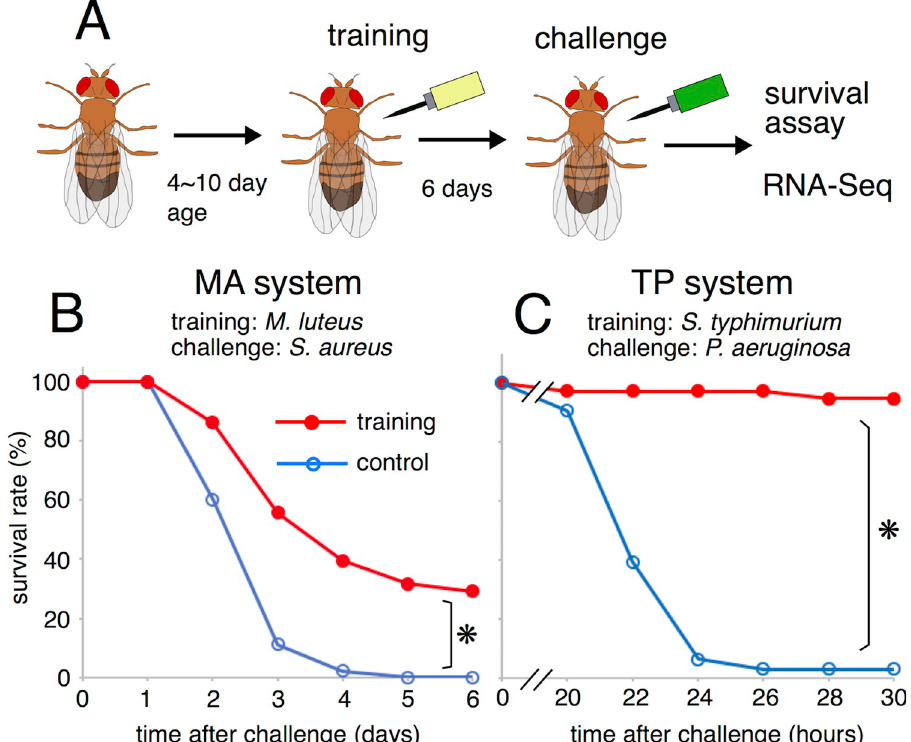
Fig 1. Experimental system of Drosophila immune training. (A) Schematic drawing of systemic infection experiment. After training and challenge injections, fly survival was monitored, and RNA-Seq analysis was performed. (B) Survival curves of MA system: Ml-training and Sa-challenge. Sa (OD = 0.5) was used for this experiment. (C) Survival curves of TP system: St-training and Pa-challenge. Red and blue lines represent the flies with and without training, respectively. Asterisks indicate statistically significant (p-value < 0.05) in Log-rank test. Numbers of flies used in these experiments are (B) 40, 57 flies / 3 vials, and (C) 42, 37 flies / 3 vials (with or without training, respectively).